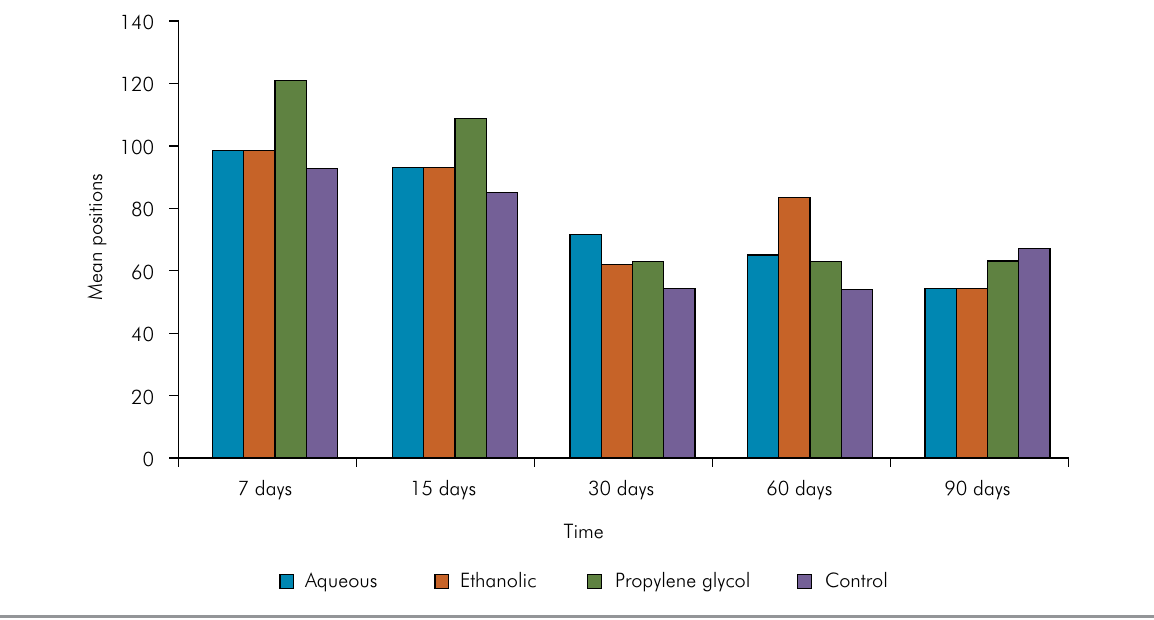
Figure 3. Graphical representation of the position occupied by the mean scores of the groups in the four periods